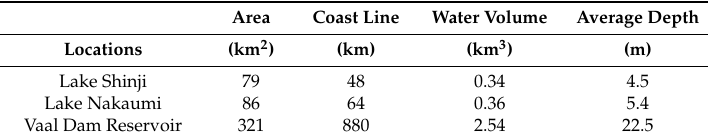
Table 1. Geographical characteristics of the target